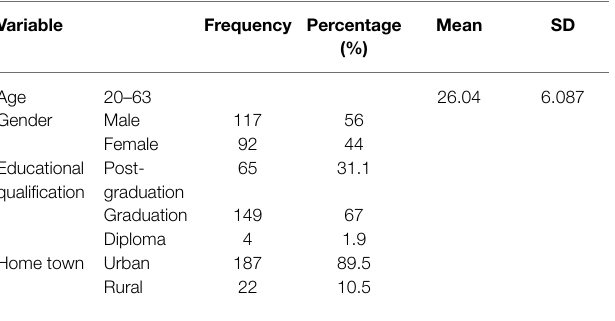
TABLE 1 | Descriptive statistics of